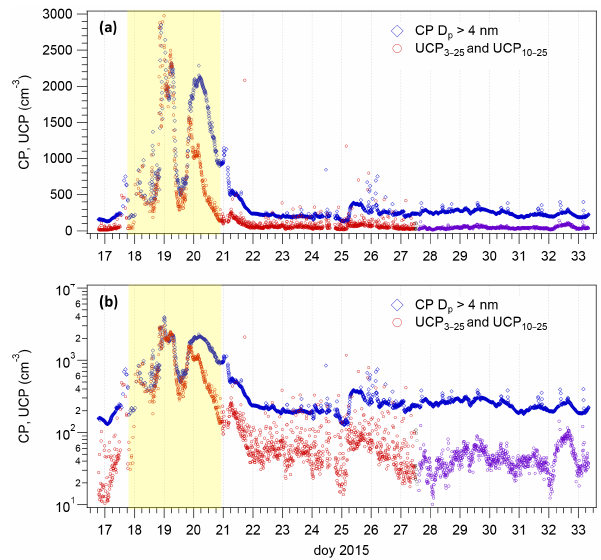
Figure 5. CP (blue diamonds), UCP 3–25 (red circles), and UCP 10–25 (purple circles) concentration time series (10min reso- lution) during the campaign 2015. UCP 3–25 and UCP 10–25 values were derived from the nano-DMA 3085 and DMA 3081 data, re- spectively. The period of LPS15 is shaded in yellow.